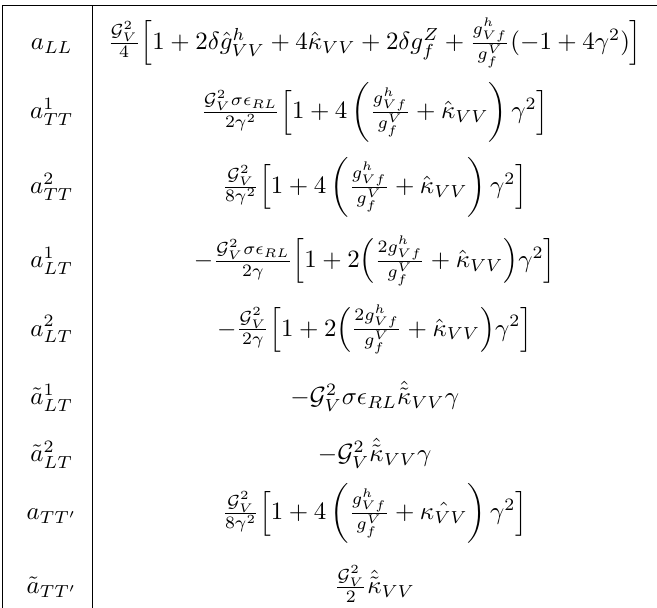
Table 2 . Expressions for the angular moments as a function of the di(cid:11)erent anomalous cou- p plings in eq. (2.1) up to linear order. Contributions subdominant in (cid:13) = ^ s= (2 m V ) are ne- glected, with the exception of the next-to-leading EFT contribution to a LL , which has been re- tained in order to keep the leading e(cid:11)ect of the (cid:14) ^ g h term. The factor (cid:15) RL is de(cid:12)ned in text and V V q G V = gg V ( g V ) 2 + ( g V ) 2 = ( c (cid:18) (cid:0) V ), (cid:0) V being the V -width. The SM part of our results can f l L l R W